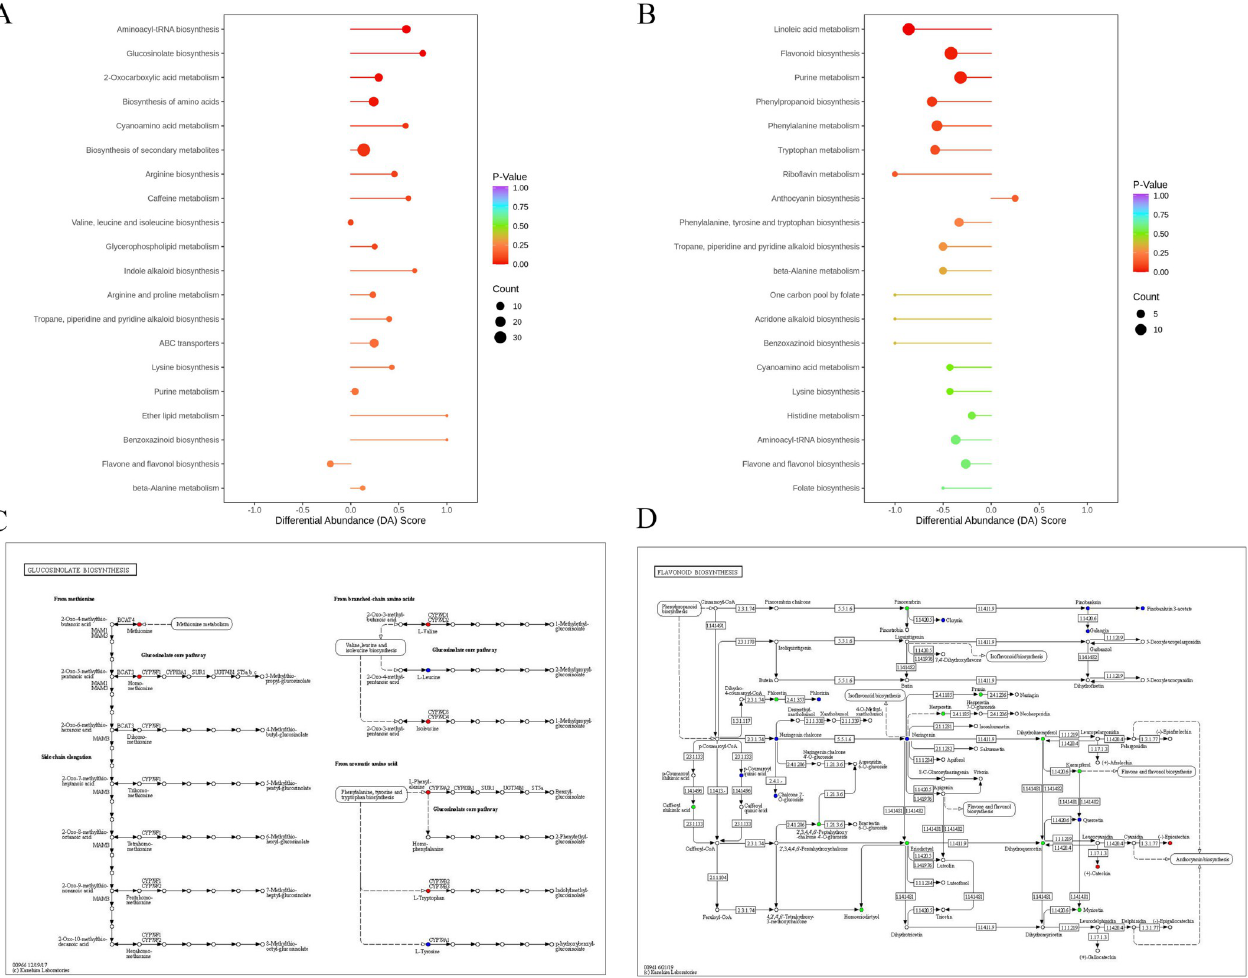
Fig 8. KEGG enrichment pathway differential metabolites. A-B. Metabolic enrichment pathway analysis in comparative groups of Pl-P vs. Pl-SP (A), and Pl- S vs. Pl-SP (B). C-D. KEGG pathway maps of glucosinolate biosynthesis (C) and flavonoid biosynthesis (D). https://doi.org/10.1371/journal.pone.0274013.g008 are flavonoids, phenolic acids, lipids and amino and derivatives. Monoterpenoides, such as paeoniflorin, oxypaeoniflorin, benzoylpaeoniflorin, lactiflorin, albiflorin and paeoniflorigen- one, are the major characteristic compounds of P . lactiflora [47,48]. This is the first time that abundant compounds of triterpene, triterpene saponin and terpene are detected in P . lactiflora